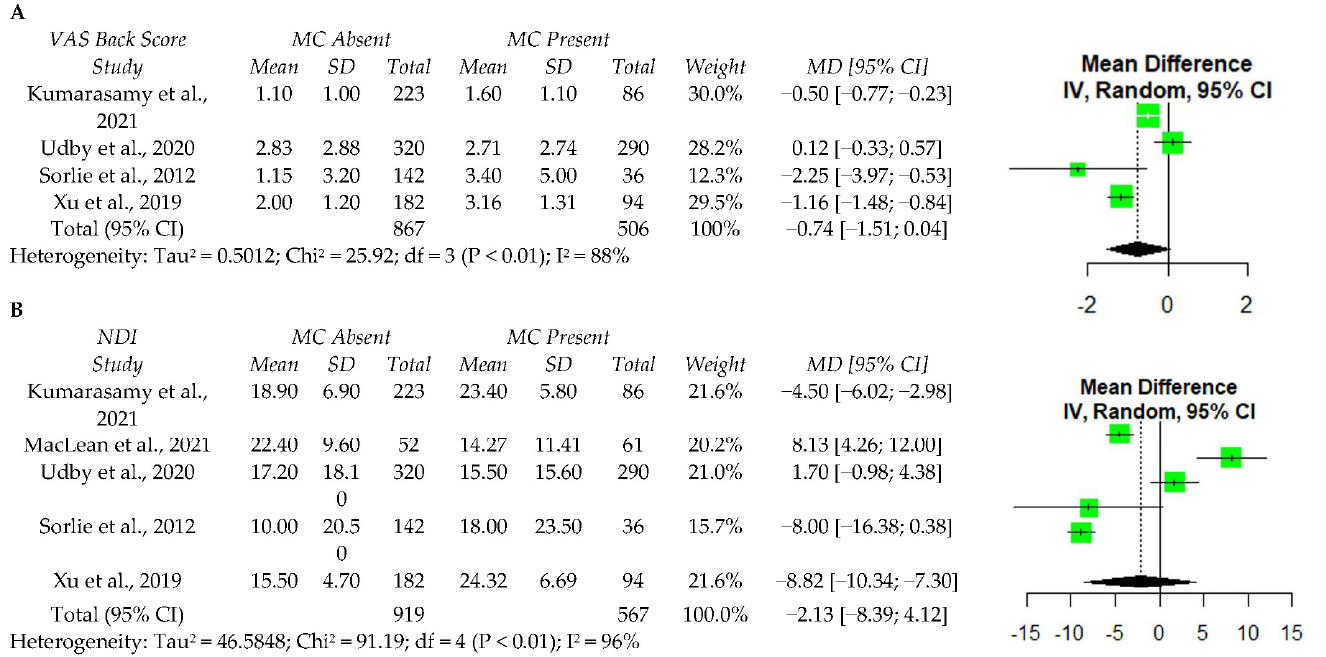
Figure 3. A meta-analysis of one year postoperative VAS back score ( A ) and ODI ( B ) following discectomy. VAS—visual analog scale; MC—Modic changes; SD—standard deviation; MD—Mean difference; CI—confidence interval; NDI—Neck Disability Index; df—degrees of freedom; IV—independent variable [21,23,44,45,50].